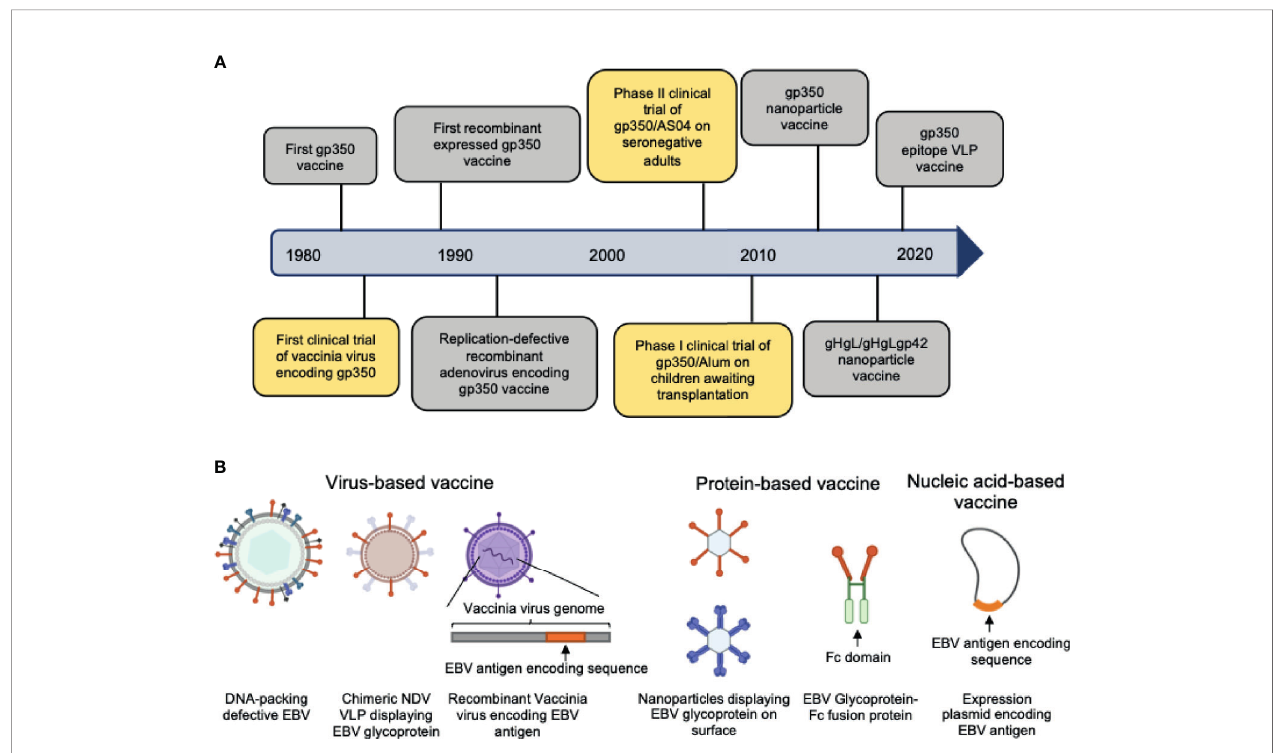
FIGURE 2 | (A) Hallmarks of prophylactic EBV vaccine development using EBV glycoproteins as antigens. Clinical trials are marked in yellow box and others are marked in gray box. (B) Current candidate platforms for EBV vaccines, including virus-based, protein-based and nucleic-acid-based